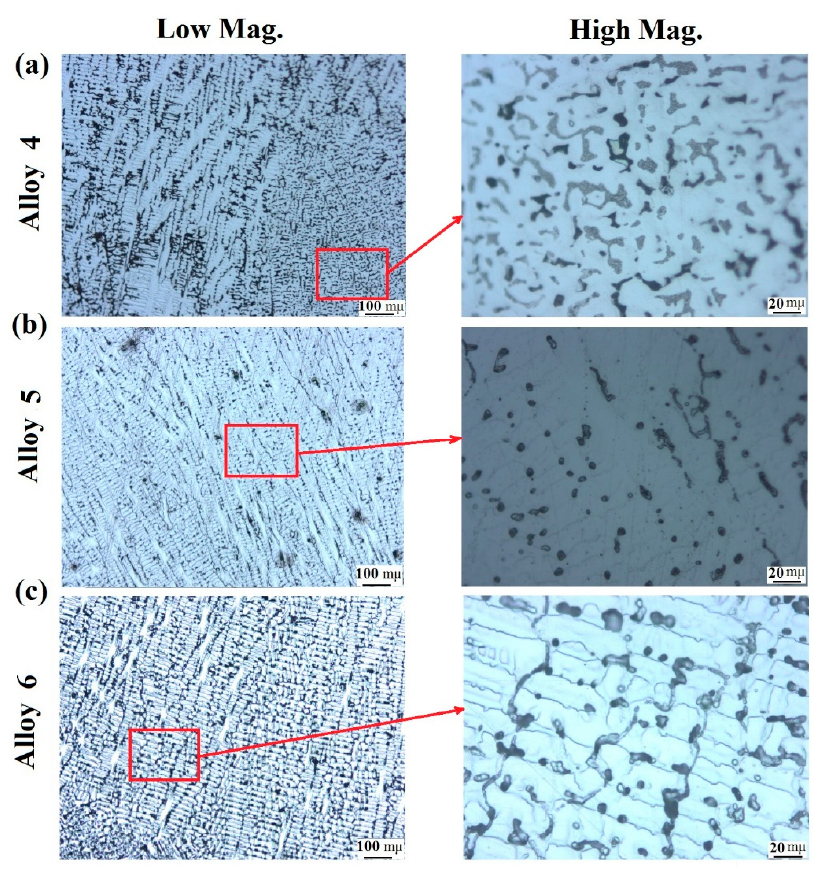
Figure 9. Microstructural images of as-cast HEAs ( a ) Alloy 4, ( b ) Alloy 5, and ( c ) Alloy 6. Low and high magnification are presented in left and right, respectively.